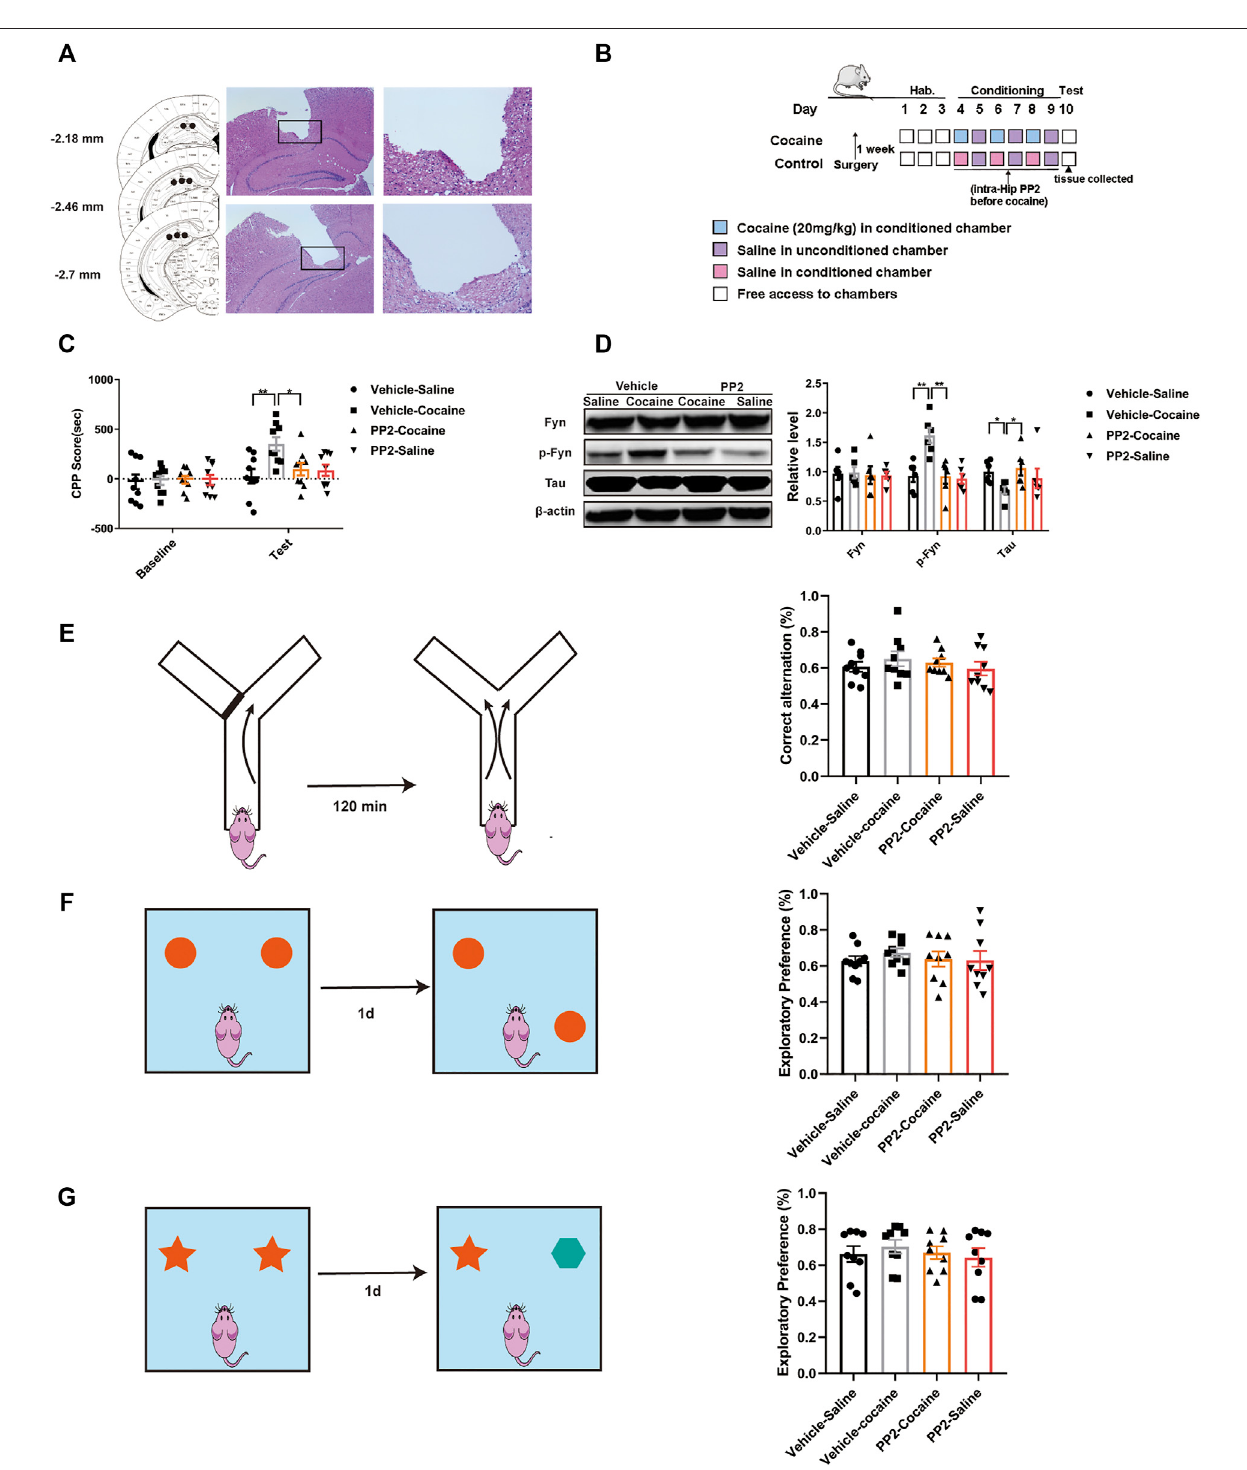
FIGURE 1 | PP2 infusion into the hippocampus reduced the cocaine CPP score. (A) Schematic representation of the hippocampal cannula placements and injection sites. (B) Experimental timeline for intra-hippocampal injection of PP2 in the cocaine CPP test. (C) Inhibition of Fyn activity by PP2 signi fi cantly attenuated the cocaineCPPscore( n =9pergroup). (D) ImmunoblottingofFyn,phosphorylatedFyn,andTauexpressioninthehippocampusofcocaineCPPmice( n =6pergroup). (E) No signi fi cantdifferences were observed between groups in the Y-maze test ( n = 9per group). (F, G) PP2-treated mice failed to exhibiting exploratory preferences in the novel object position test and novel object recognition test ( n = 9 per group). Data are the means ± SEM, * p < 0.05 and ** p < 0.01. Hab, habituation; p, phosphorylated; Hip, hippocampus.